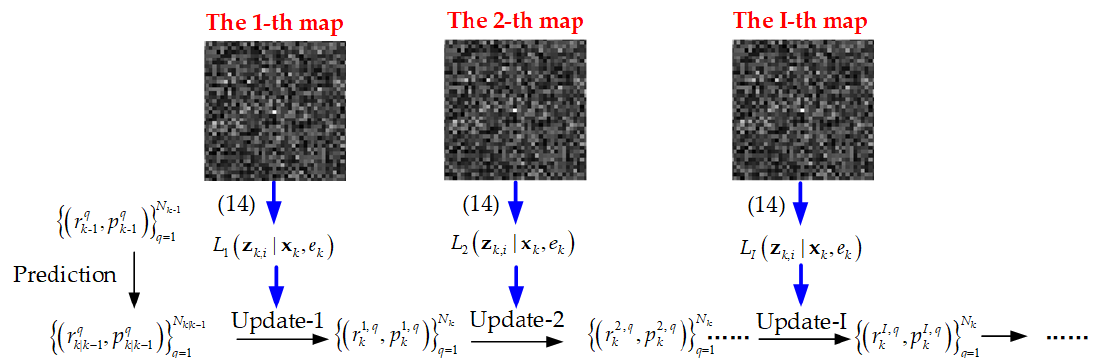
Figure 5. Propagation track table of iterated-corrector multi-Bernoulli (ICMB) filter at time k .